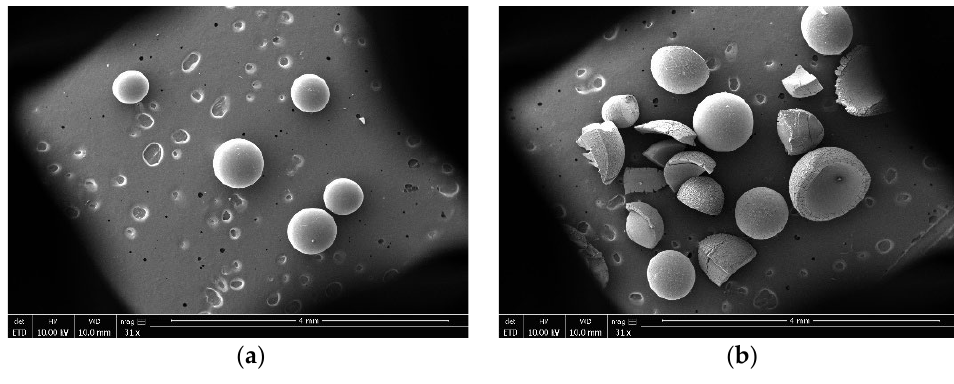
Figure 2. SEM photomicrographs of NKC − 9 catalyst ( a ) fresh and ( b ) used.